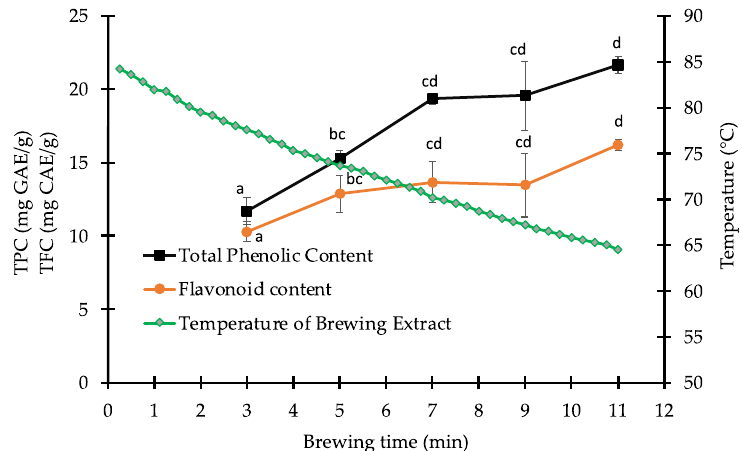
Figure 2. Extractability of total phenolic content (TPC) and total flavonoids (TFC) and the change of infusion temperature at different brewing time. Data are means ± standards deviations. Data for each phytochemical group (TPC or TFC) not sharing similar letters are significantly different at p < 0.05.